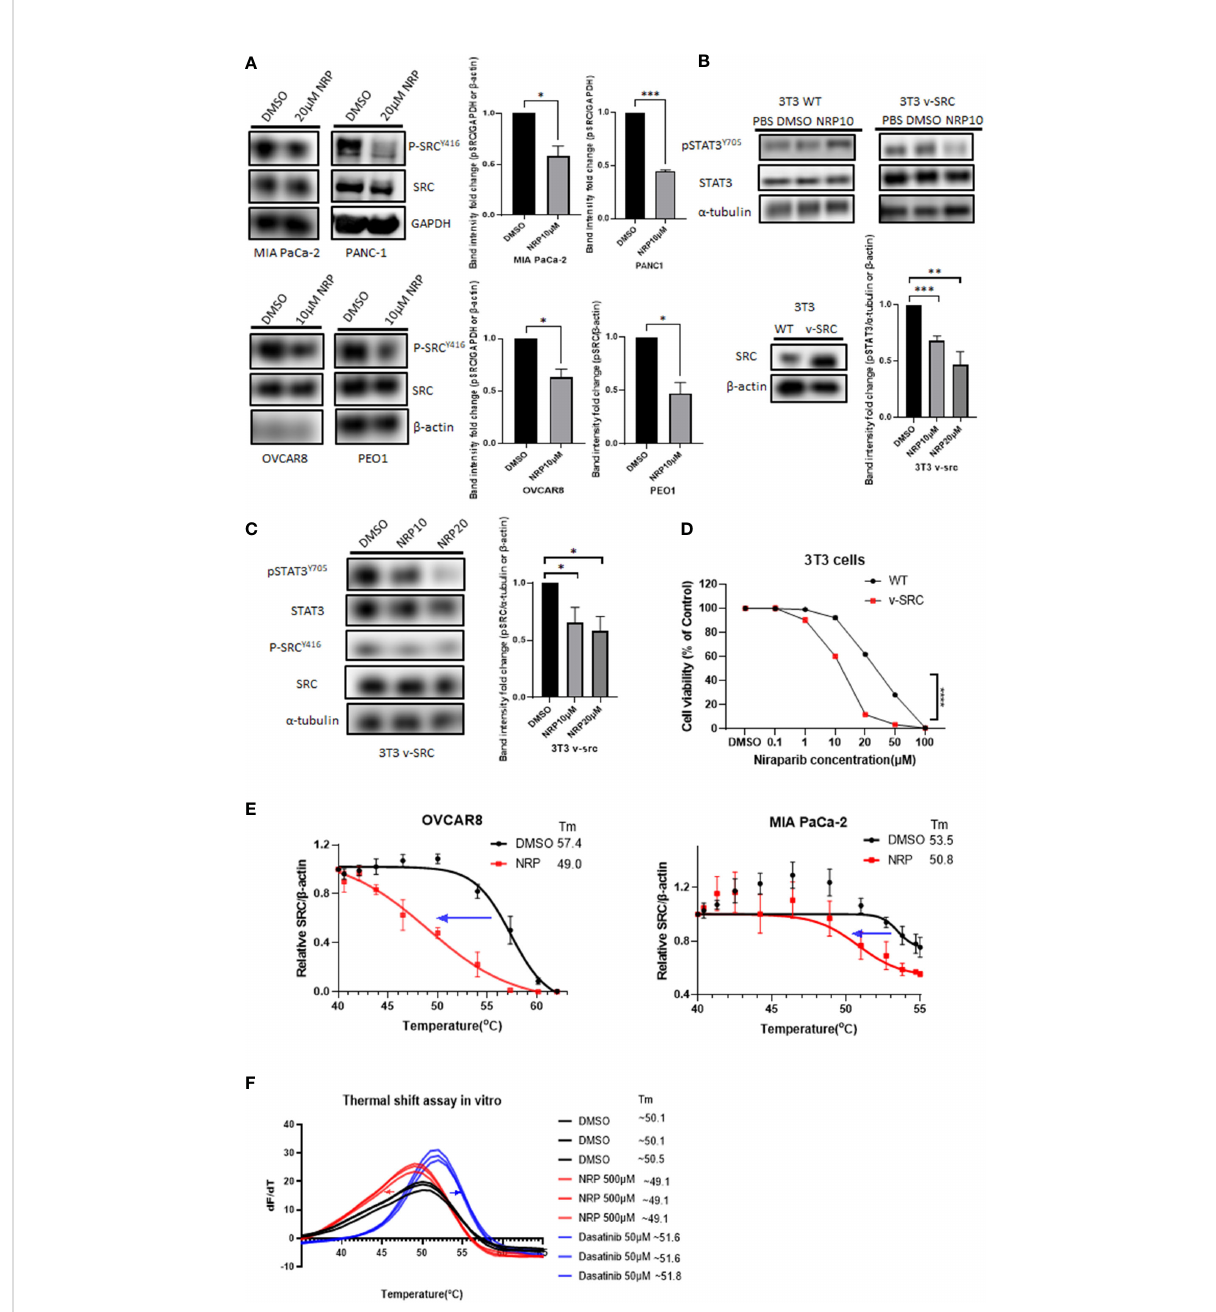
FIGURE 3 pSRC was downregulated along with reduced pSTAT3 post NRP treatment. (A) pSRC in cell lysates described in Figure 2A detected by Western blot. GAPDH or b -actin served as the loading control. Band intensities from two or three independent experiments were quanti fi ed by ImageJ and showed in a bar graph as mean ± SEM (B) 3T3 WT or 3T3 v-SRC cells were treated with DMSO or 10 µM NRP for 24h, and cell lysates were analyzed by Western blot. a -tubulin was detected as the loading control. The right panel shows the protein level of ectopic expression of SRC in 3T3 v-SRC cells by Western Blot. b -actin served as the loading control. Band intensities from three independent experiments were quanti fi ed by ImageJ and showed in a bar graph as mean ± SEM (C) The level of pSRC was examined in 3T3 v-SRC cells treated with 10 µM or 20 µM NRP for 24h by Western blot. a -tubulin was used as the loading control. Band intensities from three independent experiments were quanti fi ed by ImageJ and showed in a bar graph as mean ± SEM (D) Cell viability of 3T3 v-SRC or wild-type 3T3 cells after NRP treatment was measured by CellTiter-Glo assay. A representative graph of three independent experiments is shown. (E) Thermal stability of endogenous SRC in MIA PaCa-2 or OVCAR8 cells was measured by in-cell thermal shift assay as described in Materials and Methods. Data are shown as mean ± SEM (N=3). (F) In vitro thermal shift assay was performed in triplicate using human recombinant SRC protein in the presence of DMSO control, NRP, or Dasatinib (positive control). For each condition, all three SRC protein melting curves are shown. *p<0.05, **p<0.001,